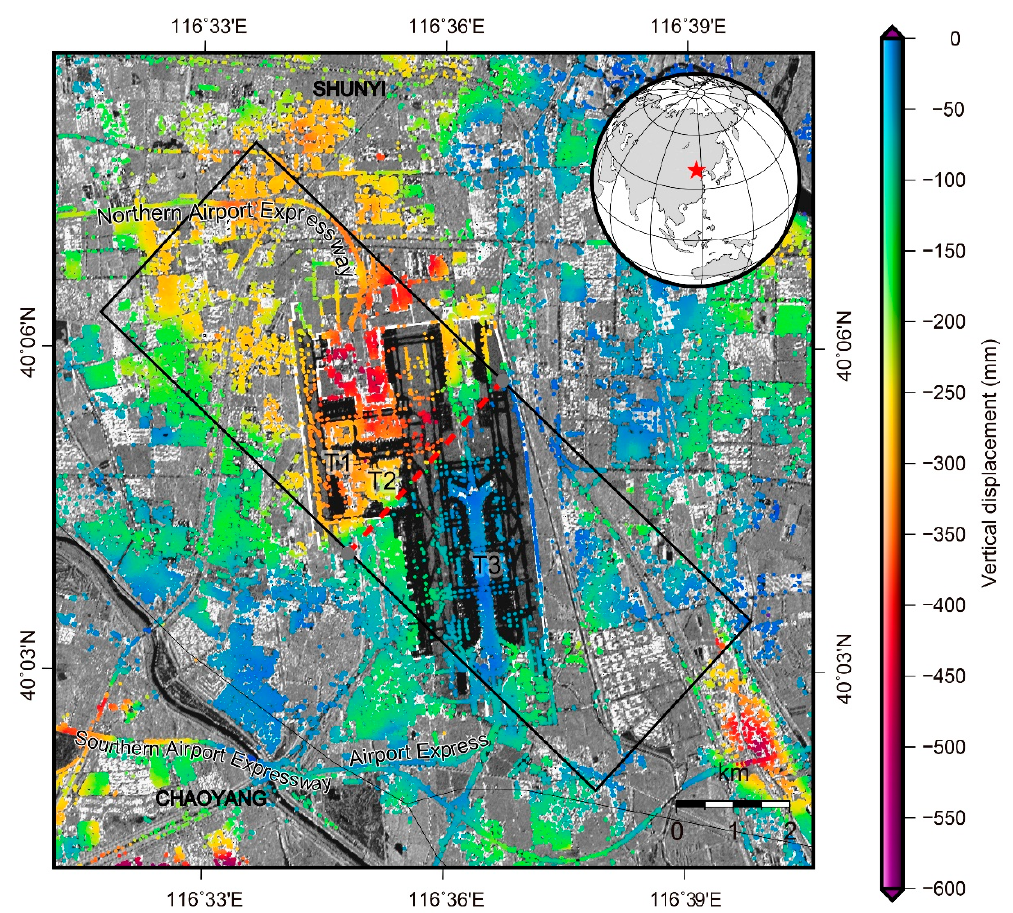
Figure 8. The distribution of the cumulative vertical displacement (mm) derived from the time series InSAR approach in the study area between 2010 and 2017. The red dashed line indicates the location of the primary ground fissure identified by InSAR measurements. Data within the black box are shown in Figure 9.